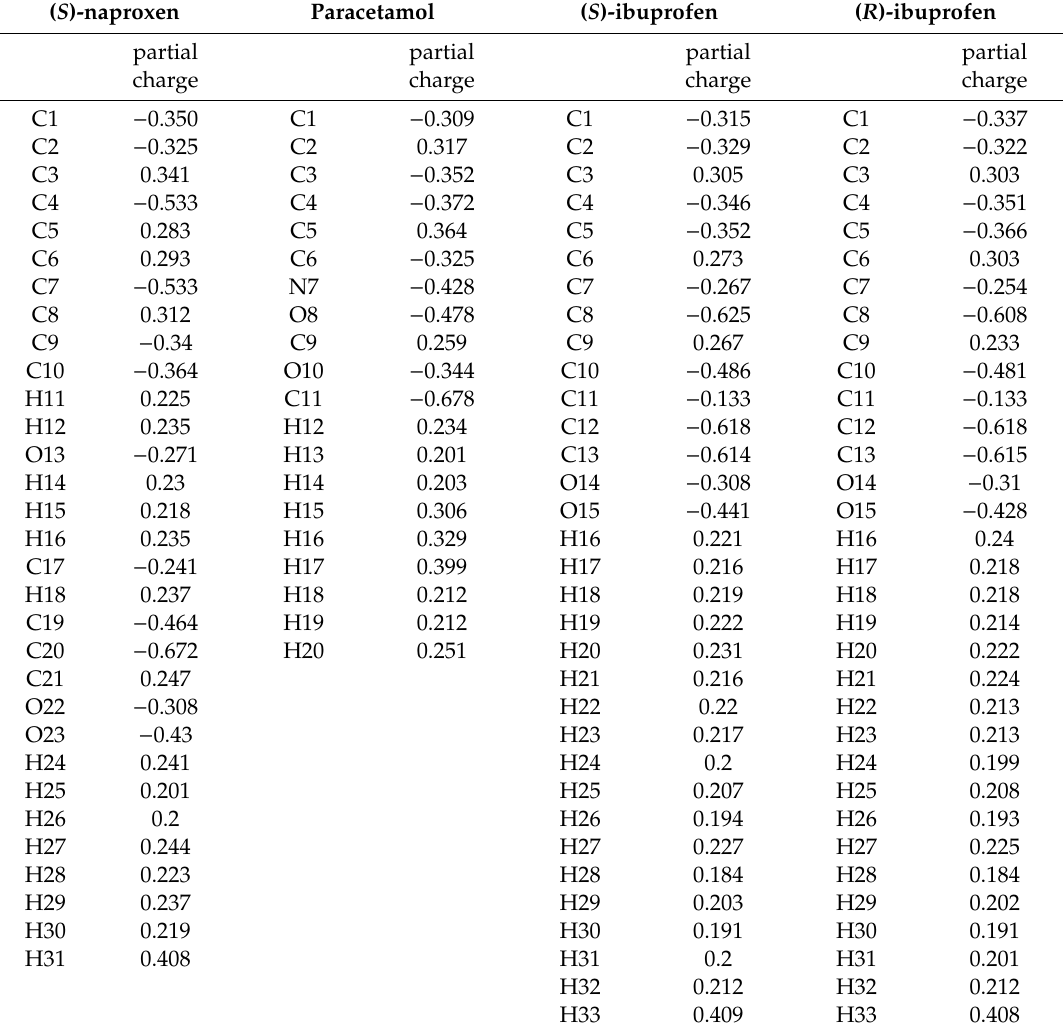
Table 2. Calculation results for ( S )-naproxen, paracetamol, ( S )-ibuprofen and ( R )-ibuprofen obtained in SCIGRESS